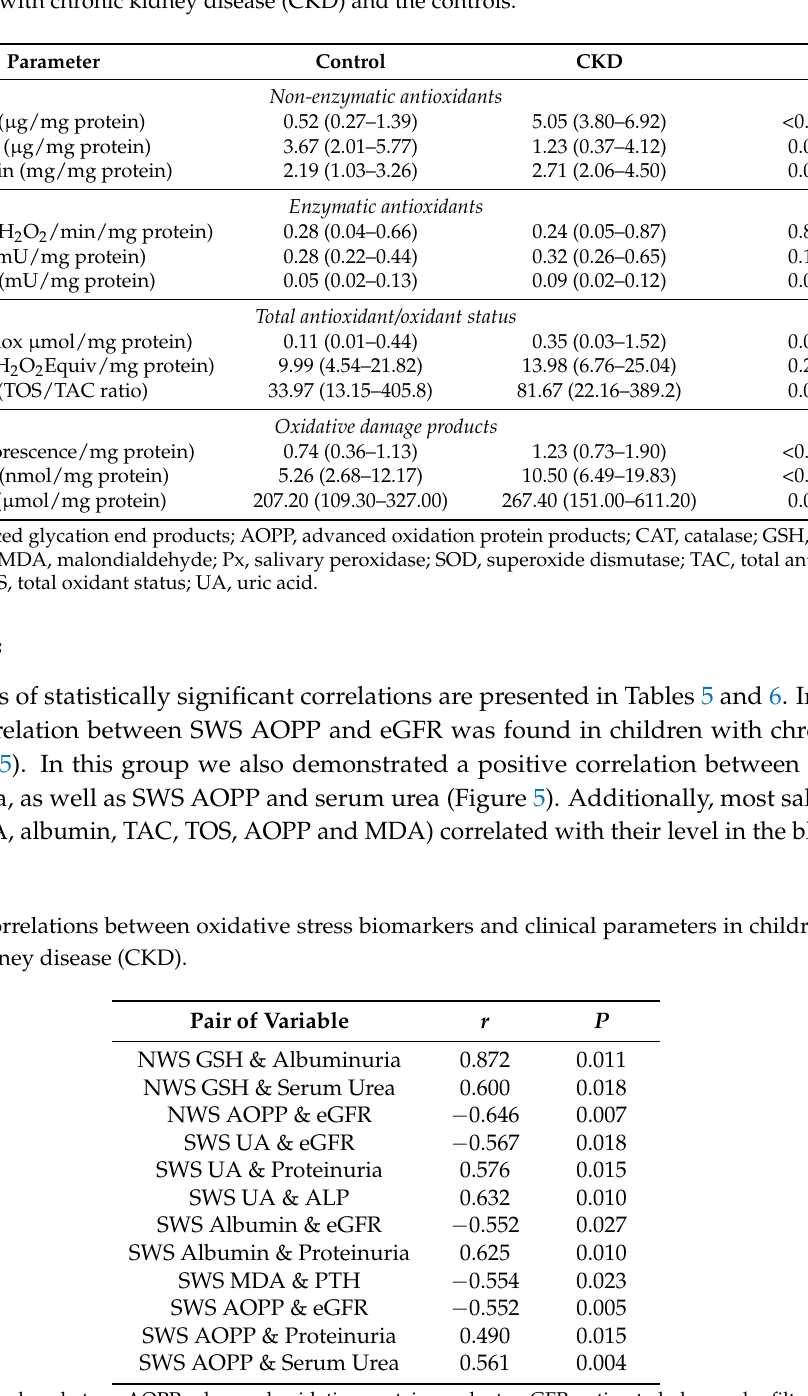
Table 4. Erythrocytes and plasma antioxidants, total antioxidant/oxidant status and oxidative damage in children with chronic kidney disease (CKD) and the controls.